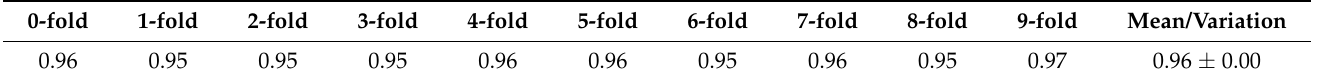
Table 8. Results of classification in terms of mean/variance on 10-fold cross-validation.